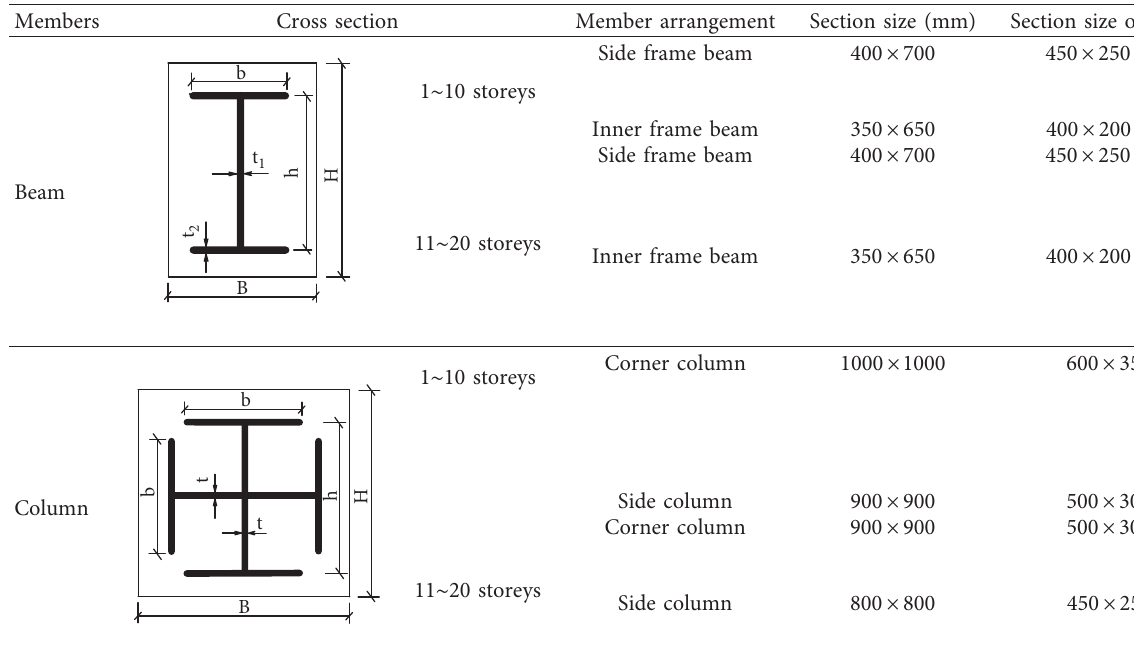
Table 2: Section size of the members in the SRC frame-core tube structure.